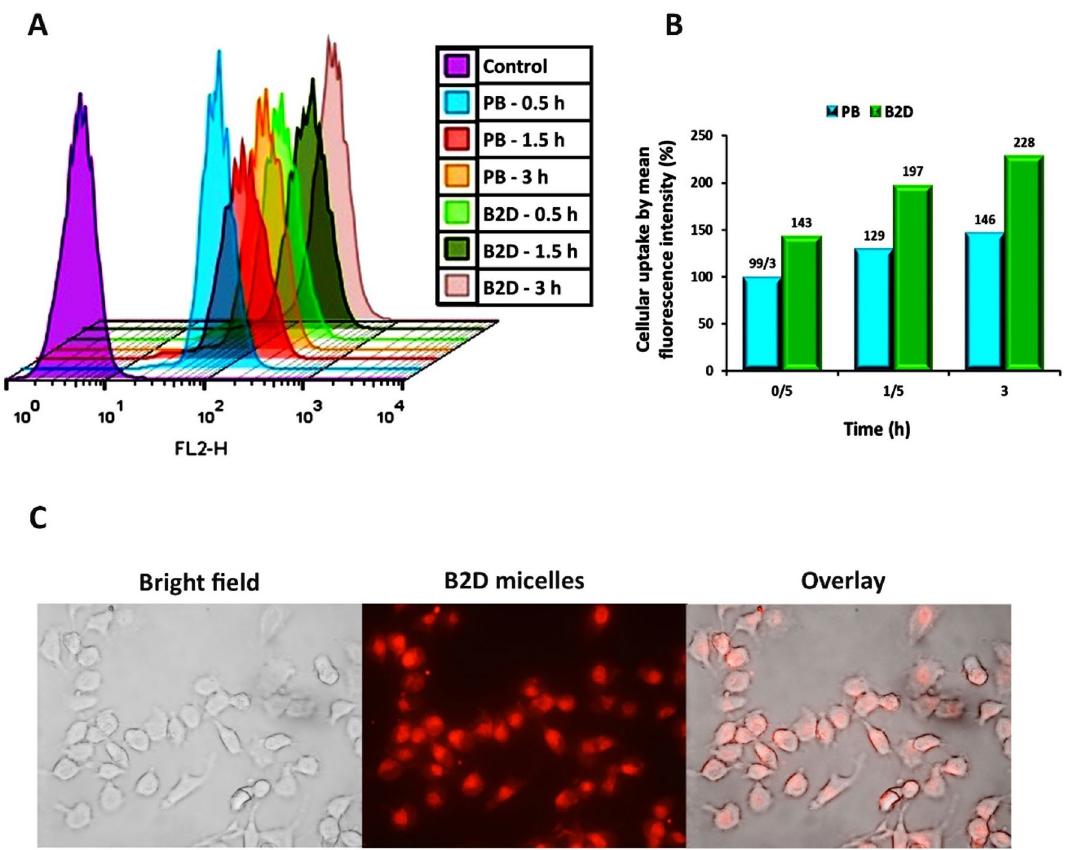
Figure 5. ( A ) Results of intracellular uptake of rhodamine B-labeled blank βCD-g-PMA-co-PLGA micelles ( PB : 20 µg/mL) and rhodamine B-labeled co-drug loaded βCD-g-PMA-co-PLGA micelles ( B2D : 2 µg/mL) by MDA-MB-231 cells in different time intervals: 0.5, 1.5 and 3 h, using flowcytometry; ( B ) Diagram of mean fluorescence intensity (%) of rhodamine B-labeled PB and B2D that were uptaken by MDA-MB-231 cells in different time intervals: 0.5, 1.5 and 3 h, using flowcytometry; (the differences between treatments was statistically significant, p < 0.001); ( C ) Fluorescence microscopic images of rhodamine B-labeled B2D (2 µg/mL) internalization to MDA-MB-231 cells only at 1 h, prepared by research fluorescence microscope. (Abbreviations: PB : Rhodamine B-labeled blank βCD-g-PMA-co-PLGA micelles, B2D : Rhodamine B-labeled co-drug loaded βCD-g-PMA-co-PLGA